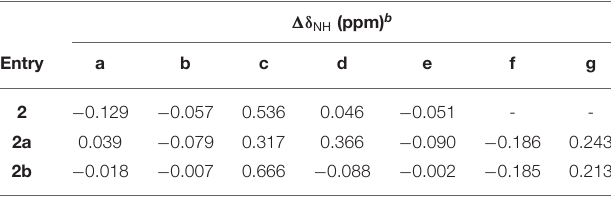
TABLE 2 | Difference in the chemical shifts of amide protons at low and high concentrations a